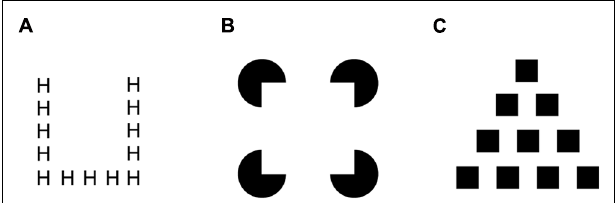
FIGURE 1 | Examples of hierarchical stimulus configurations with global and local levels of representation: (A) Navon letter, (B) Kanizsa square, and (C) hierarchical